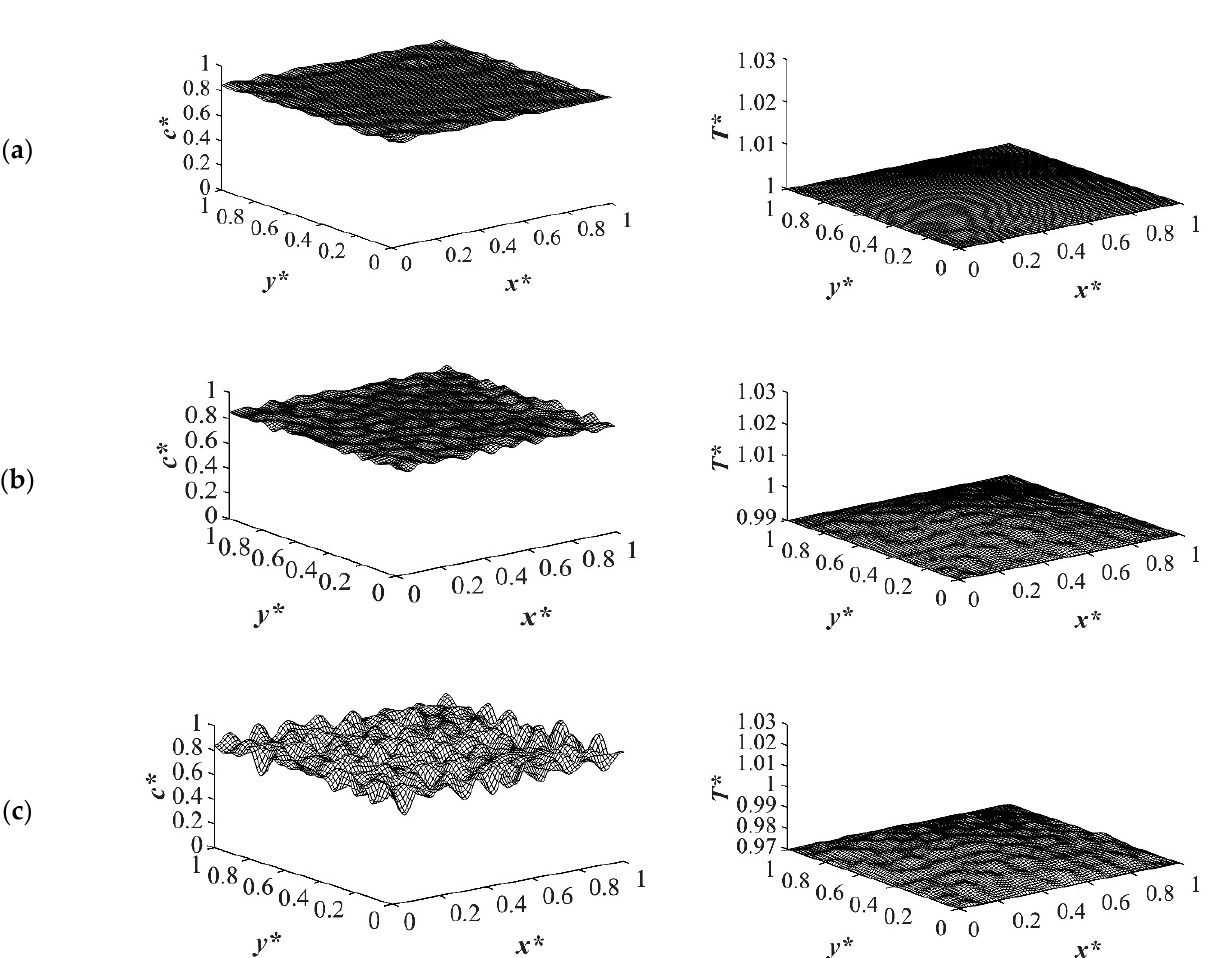
Figure 4. Spatial concentration ( left column) and temperature ( right column) profiles for the off- critical quench to c * = 0.85 at t * = 2.03 × 10 − 4 for three different quench depths of ( a ) T * q1 = 1.0, ( b ) T * q2 = 0.99 ( c ) T * q3 = 0.97.